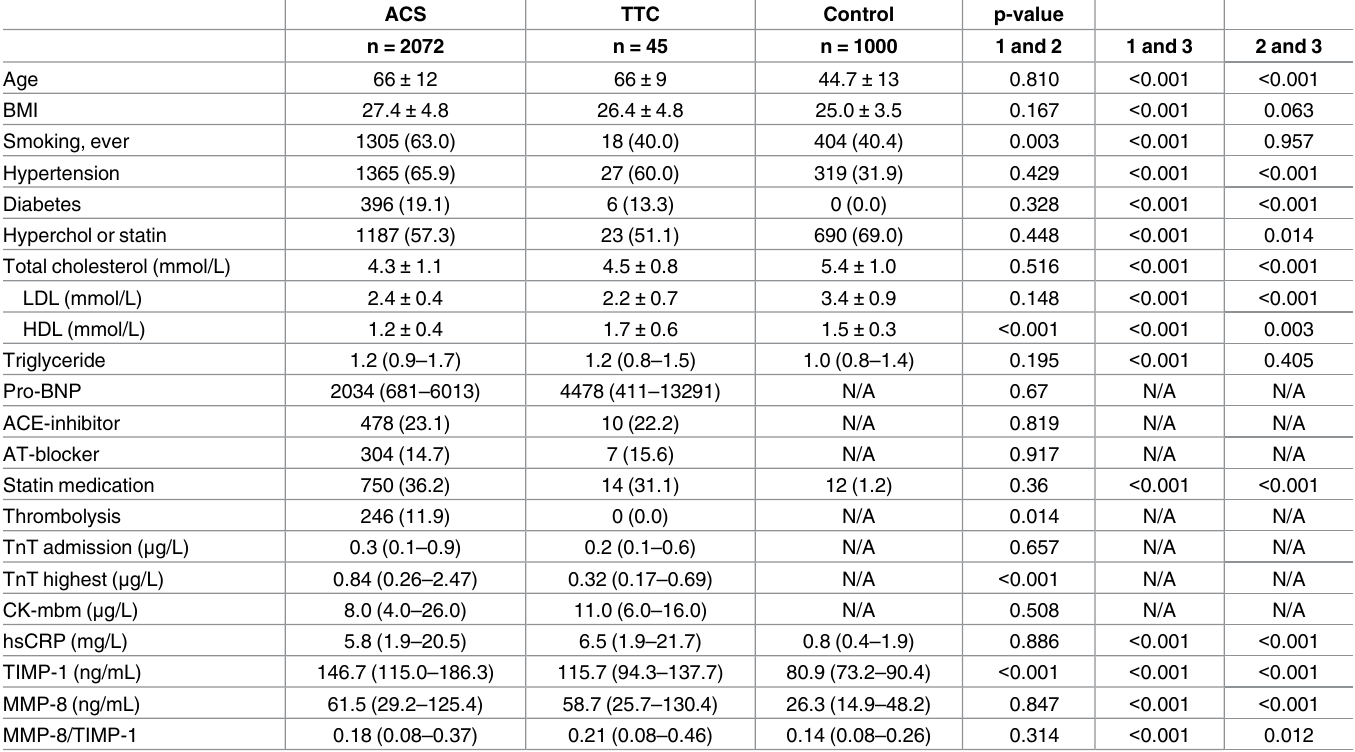
Table 1. Patient characteristics in case-control